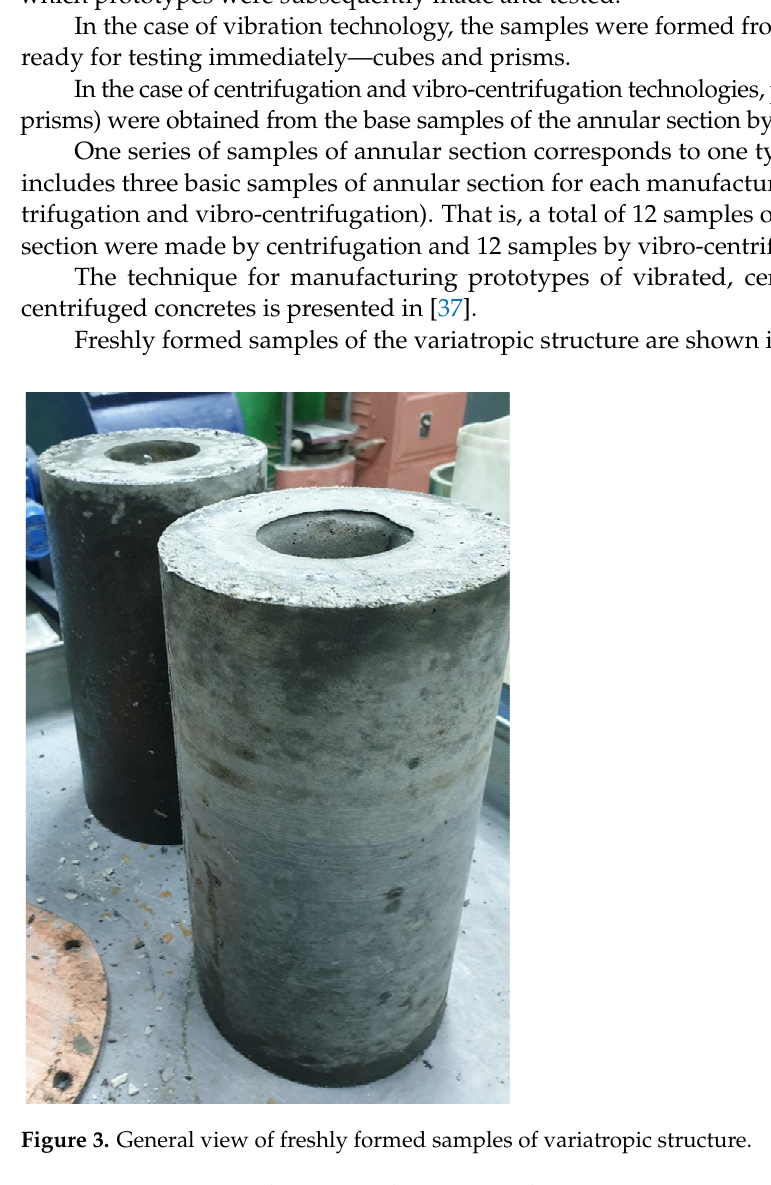
Figure 3. General view of freshly formed samples of variatropic